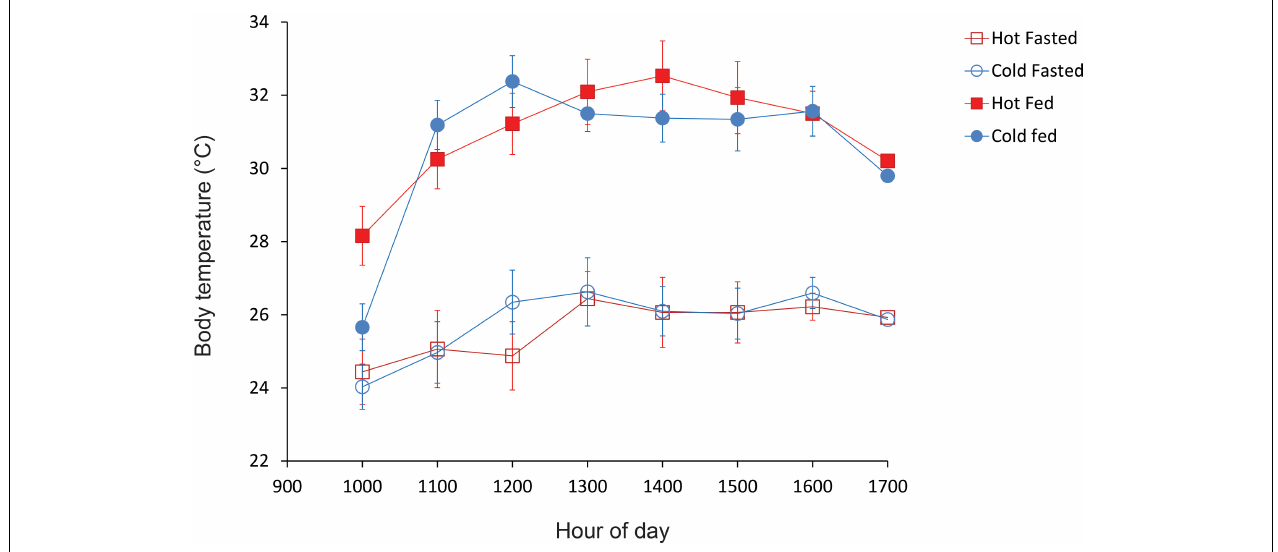
FIGURE 3 | Mean T b s of cold-incubated and hot-incubated hatchling velvet geckos that were placed inside a thermal gradient between 0900 and 1,500 h. Figure shows the temperature profiles of recently fed lizards and lizards that were fasted for 5 days. Error bars denote standard